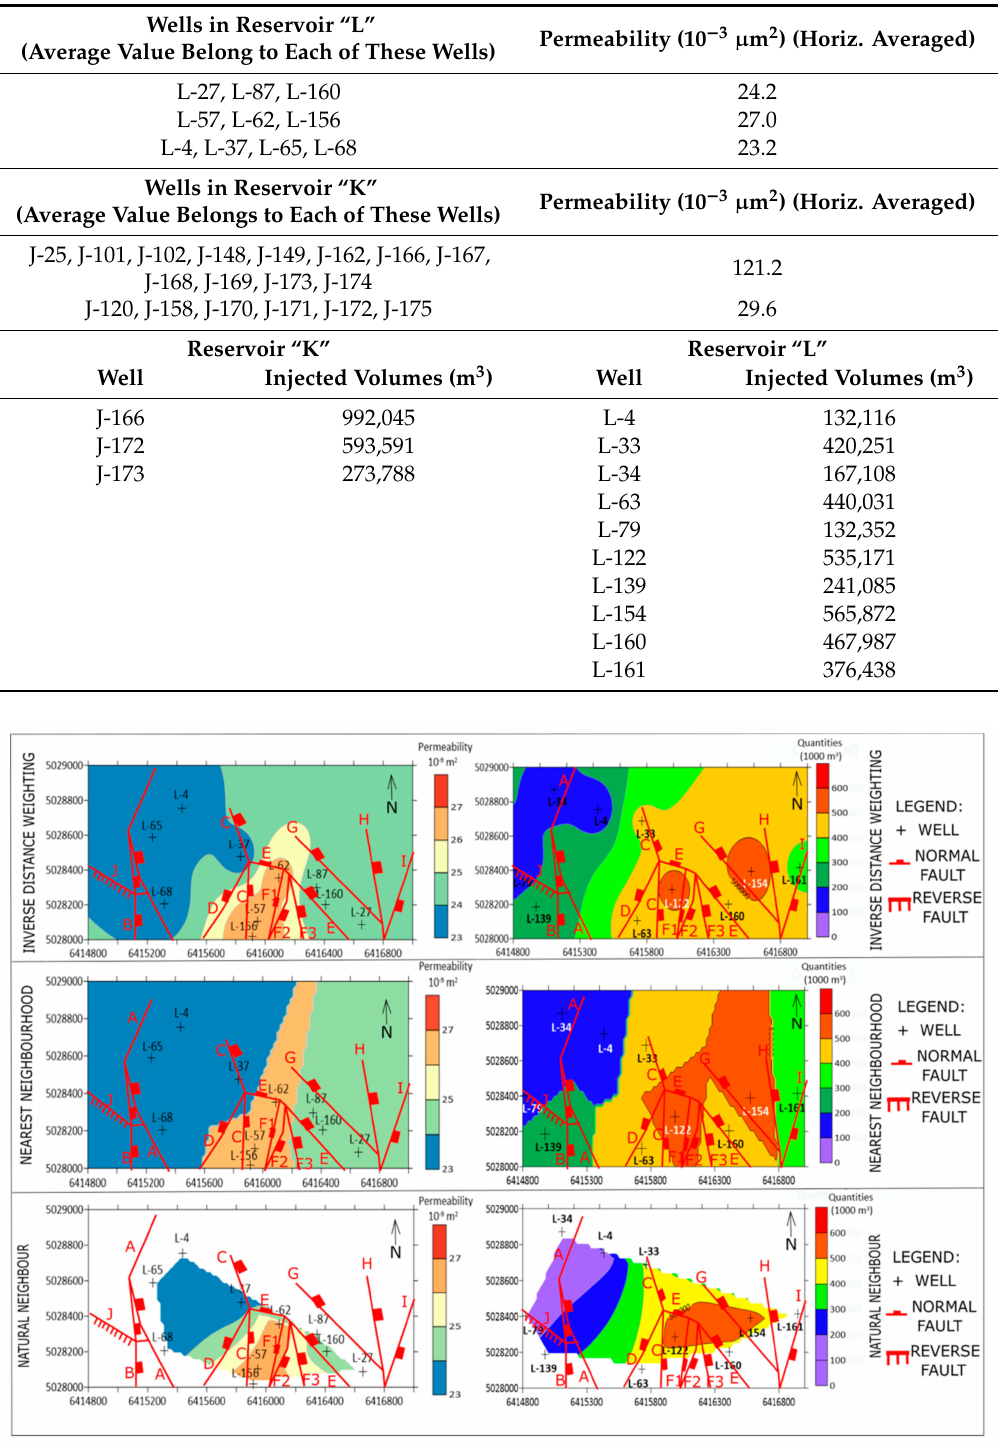
Table 1. Averaged permeabilities and total injected volumes data in the “L” and “K” reservoirs. Wells in Reservoir “L”